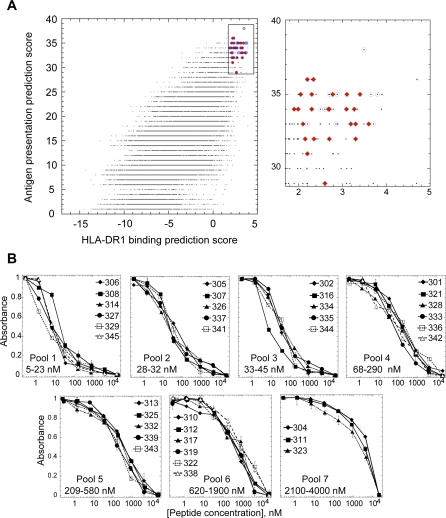
Prediction of Vaccinia-Derived HLA-DR1-Binding Peptides and Experimental Validation of Binding Affinity(A) HLA-DR1 predicted binding score and predicted antigen presentation score for each 9-mer potential peptide epitope are indicated by dots. Circles show peptides selected for further analysis (Table 1), filled circles indicate peptides for which T cell responses were observed. Inset shows high-scoring region. High-scoring peptides that were not included in the study because of synthetic difficulty are indicated by x.(B) Competition binding assay to evaluate MHC–peptide affinity. The ability of various concentrations of unlabelled MVA peptide to compete with biotinylated test HA peptide for binding to recombinant soluble HLA-DR1 was determined. Values shown (error bars) represent average (standard deviation) of three independent binding experiments. IC50 values were determined by fitting to a competition binding equation. Peptides were grouped as indicated into seven pools based on observed IC50 values.